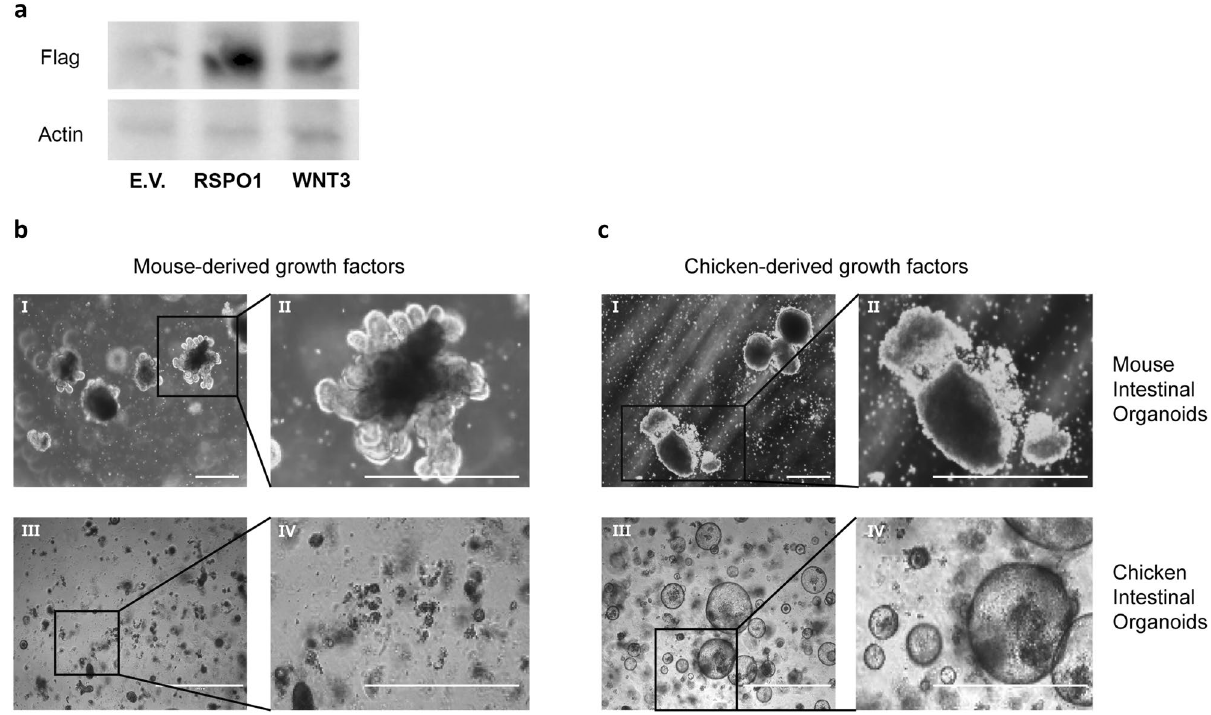
Figure 3. Growth factors RSPO1 and WNT3, from murine or chicken origin, are important for establishing intestinal organoid growth. (a) Immunoblot analysis of chicken RSPO1 and chicken WNT3 protein expression in transfected Hek293t cells. Actin was used as the protein loading control and anti-flag HRP was used to visualize RSPO1 and WNT3. Empty Vector (E.V.) is taken along as a control. (b) Brightfield images of mouse intestinal organoids (I,II) and chicken intestinal organoids (III,IV) at passage 2 (5 days after passage). Cultured in Matrigel with ICM, supplemented with Rspo1 and Wnt3 of murine origin, (c) or supplemented with chicken- derived RSPO1 and WNT3. Images and immunoblot are representative of three independent cultures. Scale bar 200